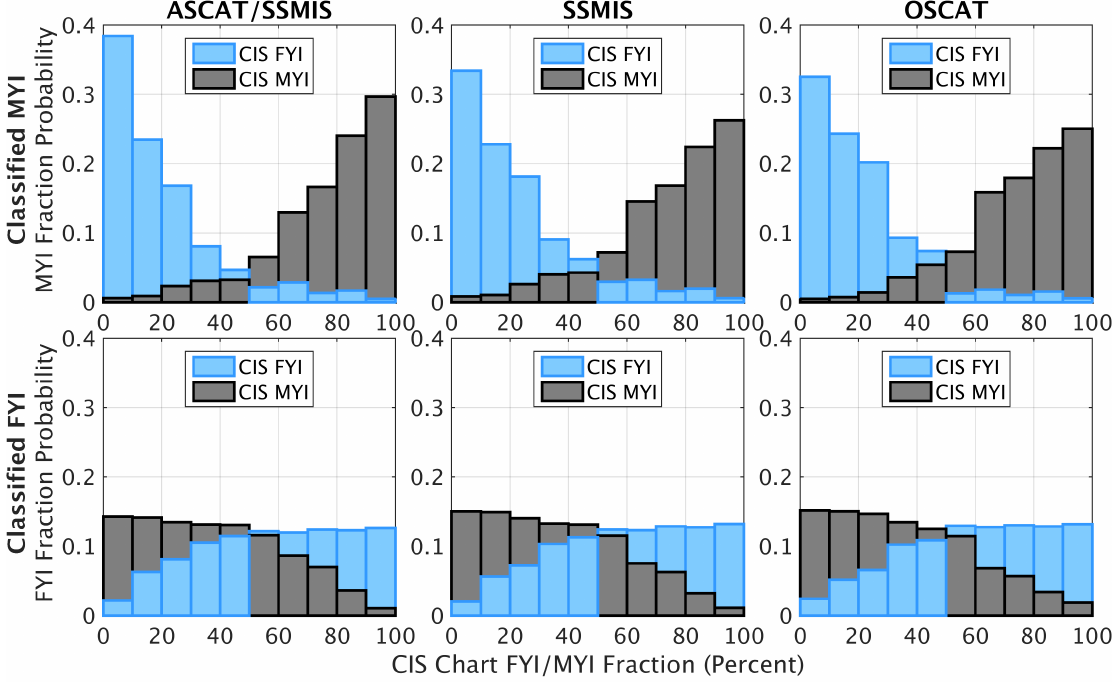
Figure 7. Probability distributions of ice classified as MY ( top ) and FY ( bottom ) with ASCAT/SSMIS ( left ), SSMIS-only ( middle ), and OSCAT ( right ) versus the CIS chart fractions of FY and MY ice. Most ASCAT/SSMIS pixels classified as MY ice (MYI) correspond to a MYI fraction of approximately 50% or greater and a FY ice (FYI) fraction of approximately 40% or less in the CIS